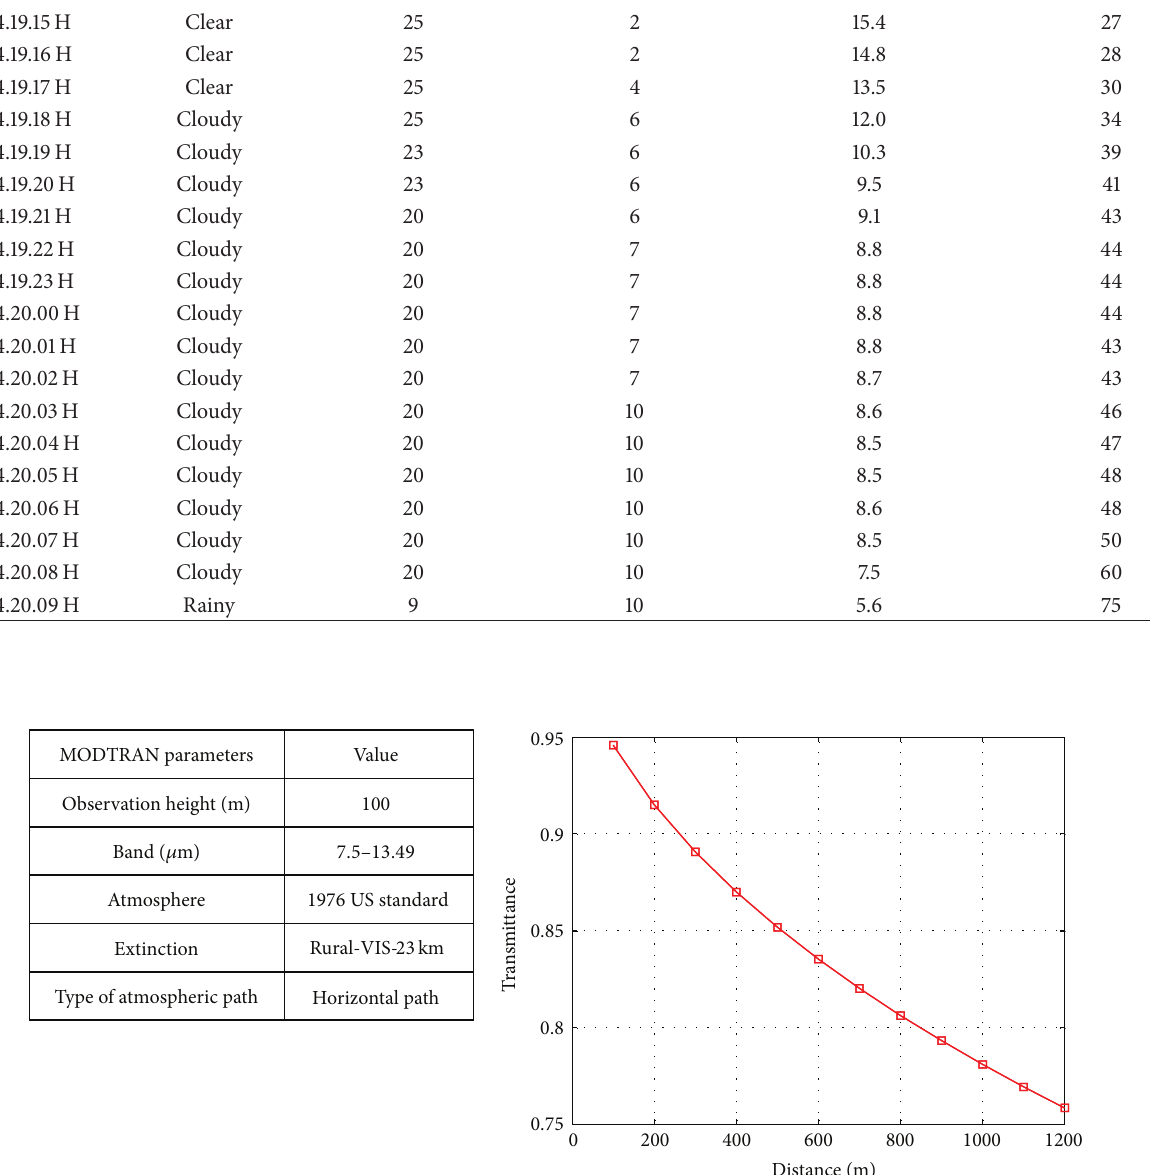
filter to the input image (Figure 10(b)). The background image can be estimated using a local mean filter with a 11 × 11 moving average kernel (Figure 10(c)). A contrast image can be obtained by subtracting the estimated background image from the pre-filtered input image (Figure 10(d)).